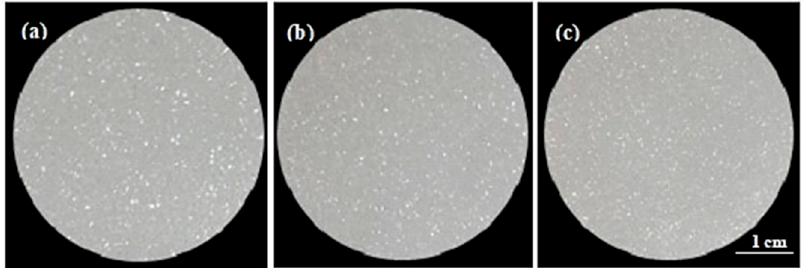
Figure 4. Macro-etched cross-sections from the bottom ash BA-6111 billets at the centre: ( a ) DC without GR, ( b ) DC with GR and ( c ) MC-DC without GR.